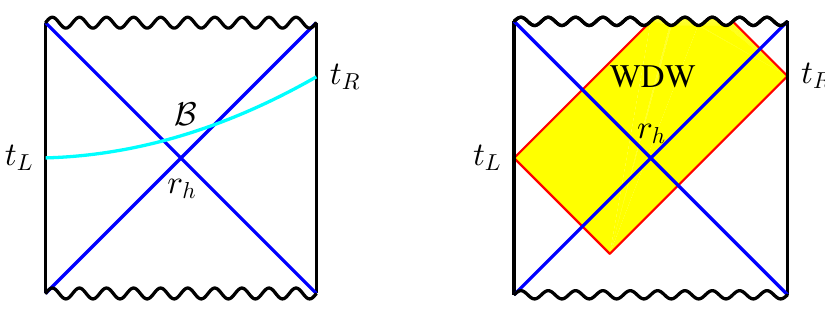
Figure 1 . Penrose diagram for Schwarzschild AdS black hole and complexity in two conjectures. At the two boundaries of the black hole, t L and t R stand for two states dual to the states in TFD. r h is the horizon radius. At the left panel, B is the maximum codimension-one surface connecting t L and t R . At the right panel, the yellow region with its boundary is the WDW patch, which is the closure (inner region with the boundary) of all space-like codimension-one surfaces connecting t L and t R